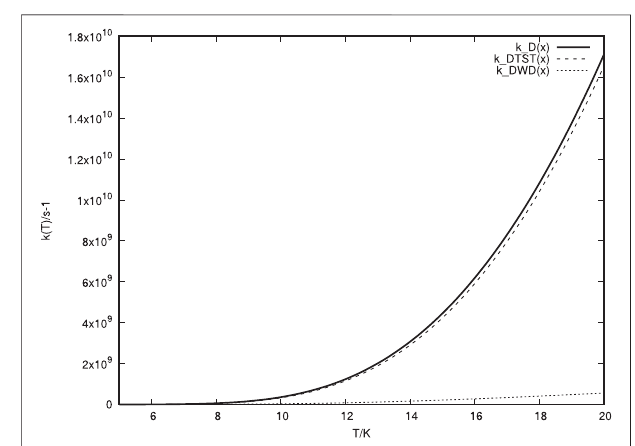
FIGURE 2 | Thermal rate constants for D atom transitions between wells. “ k-DTST (x) ” is the TST rate constant. “ k-DWD (x) ” is the tunnelling rate constant for the double well with lattice interaction. “ k-D(x) ” is the total rate constant obtained as a sum of “ k-DTST (x) ” and “ k-DWD (x) ”